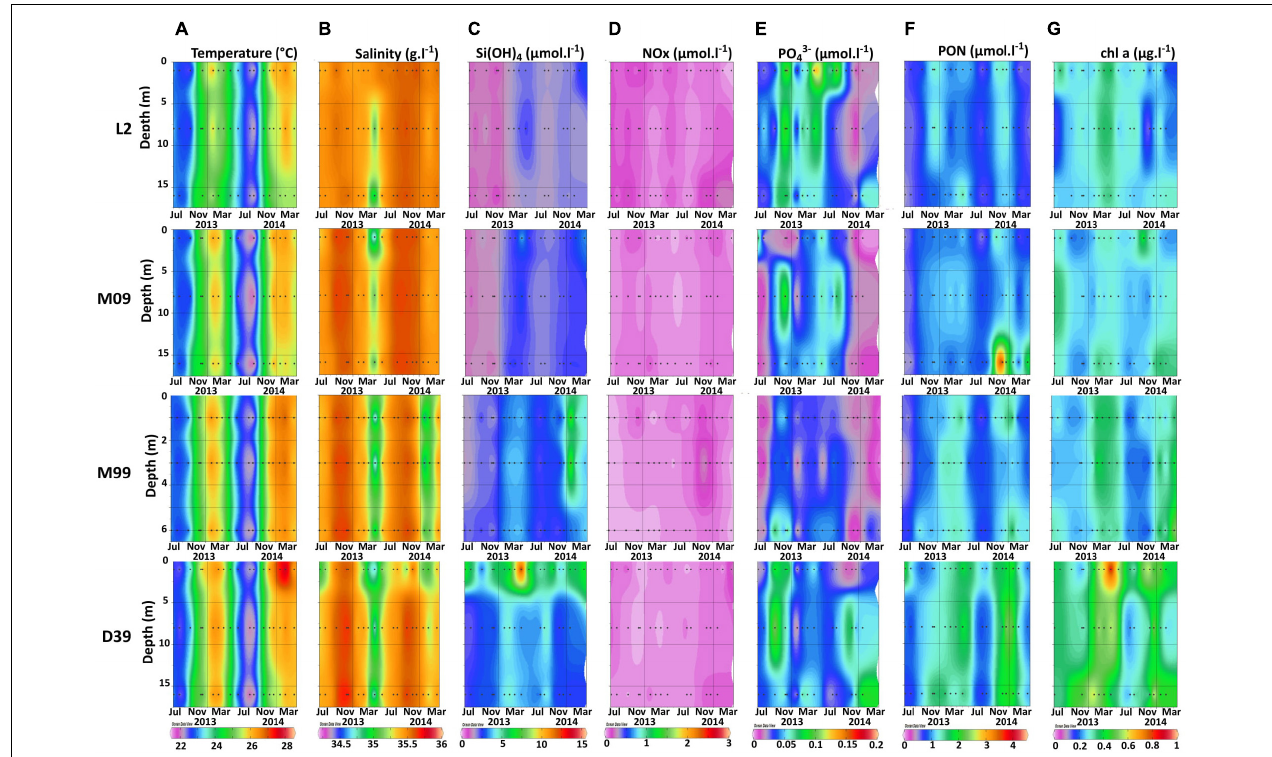
FIGURE 2 | Vertical distributions of seawater temperature (A) , salinity (B) , Si(OH) 4 concentrations (C) , NOx concentrations (D) , PO 43 − concentrations (E) , PON concentrations (F) , and chlorophyll a concentrations (G) over the 2-year survey at the stations L2, M09, M99, and